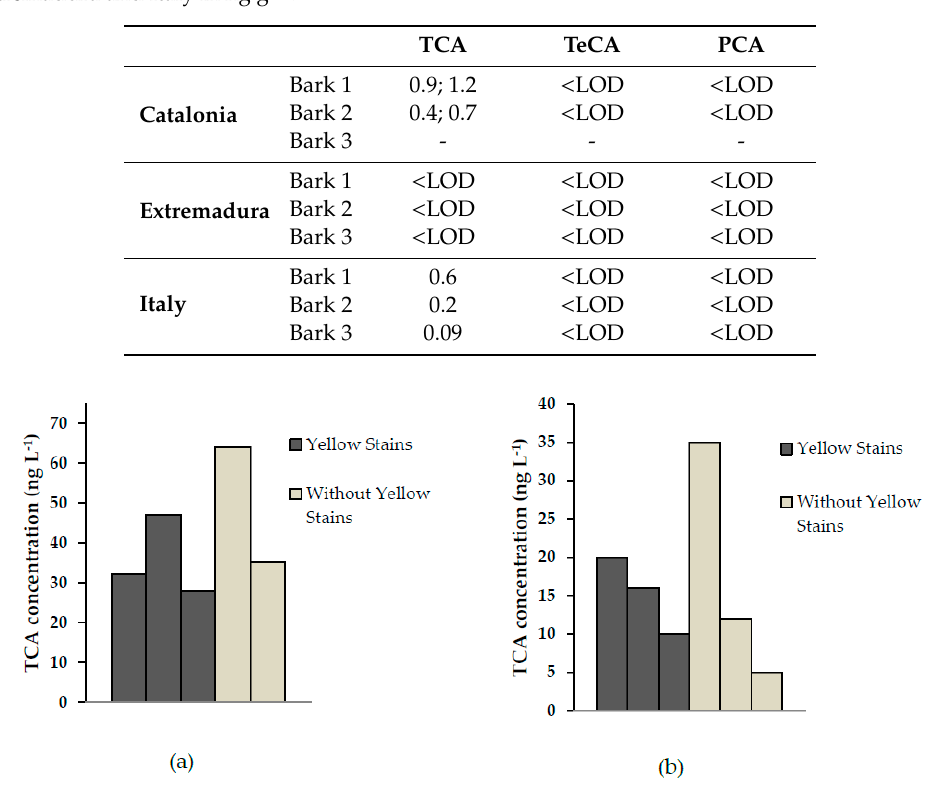
Figure 3. Comparison of the trichloroanisole (TCA) concentration in samples from ( a ) Catalonia, and ( b ) Italy with and without yellow stains.